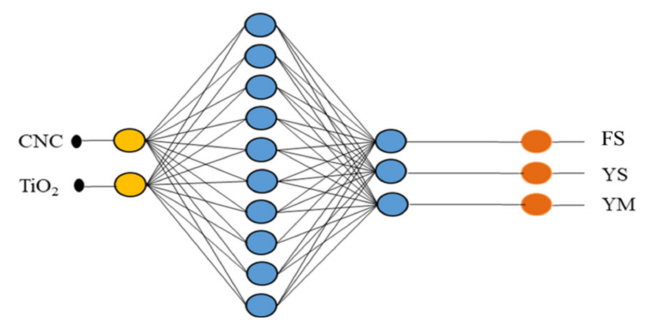
Figure 16. Final Architecture of ANN- GA network.